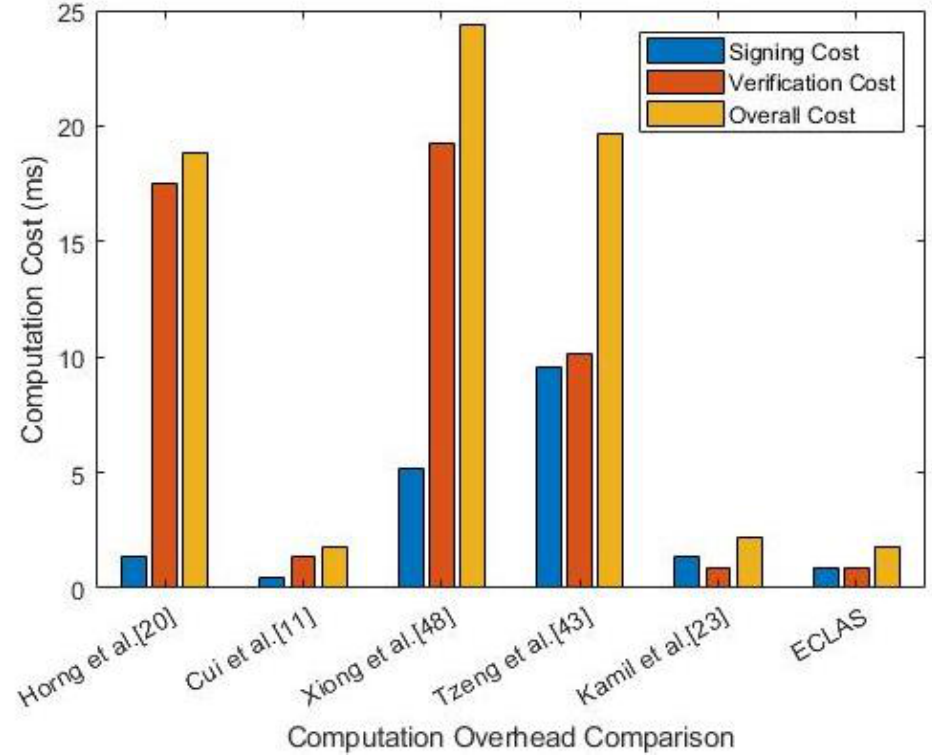
Figure 2. Computation Cost Comparison Per